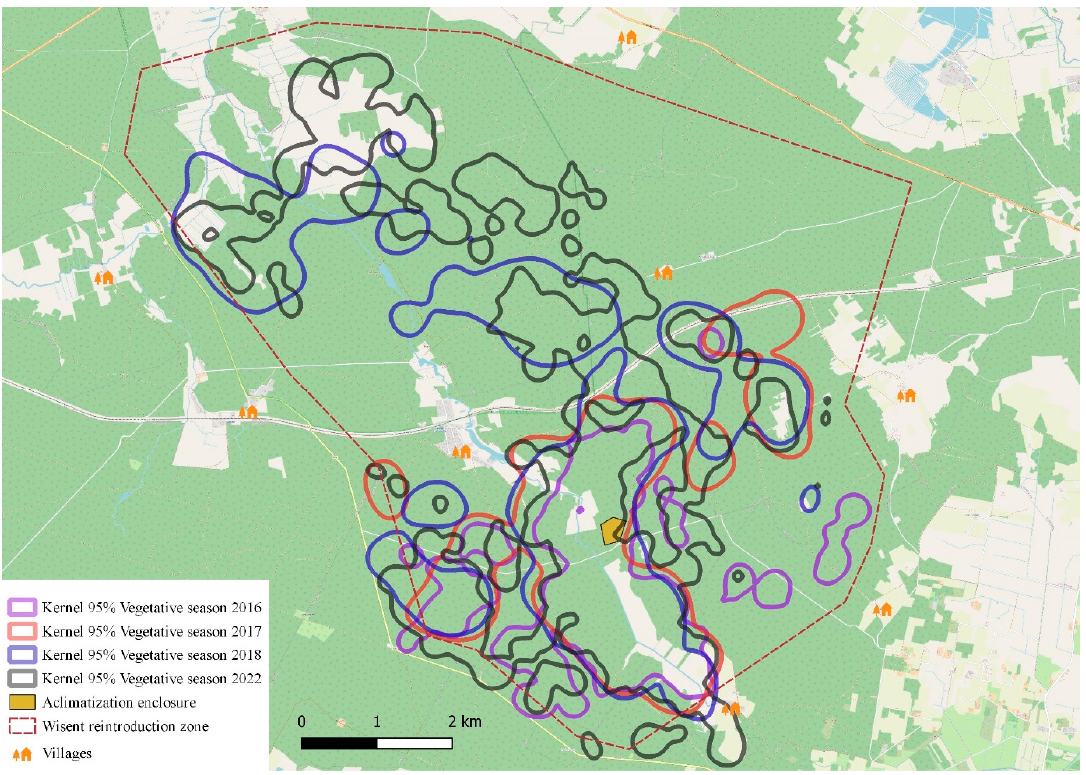
Figure 5. Kernel 95% areas during growing seasons .